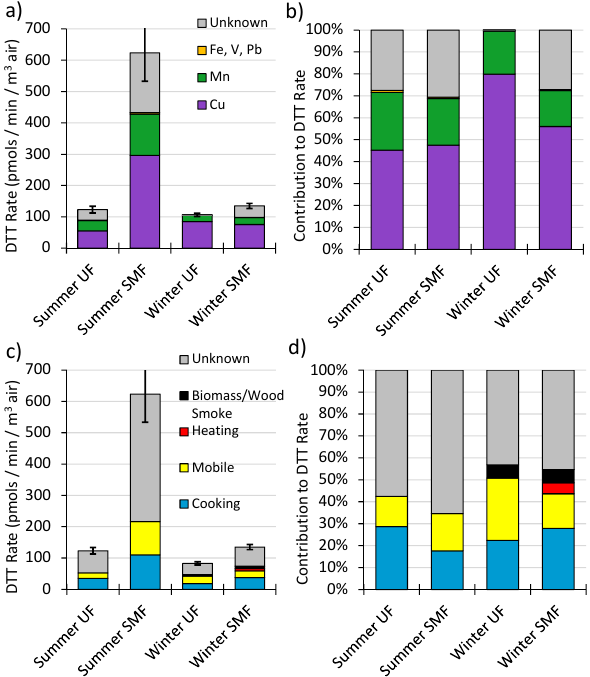
Figure 4. Panels (a) and (b) show the contributions of transition metals to the volume-normalized DTT loss for each season and size fraction, in terms of rates (a) and percent contribution (b) . Panels (c) and (d) show the contributions of known (and unknown) parti- cle emission sources to DTT loss, both in terms of rate (c) and per- cent contribution (d) . “Unknown” in (a) and (b) indicates chemical species that contribute to DTT response besides measured metals. “Unknown” in (c) and (d) indicates unknown or other